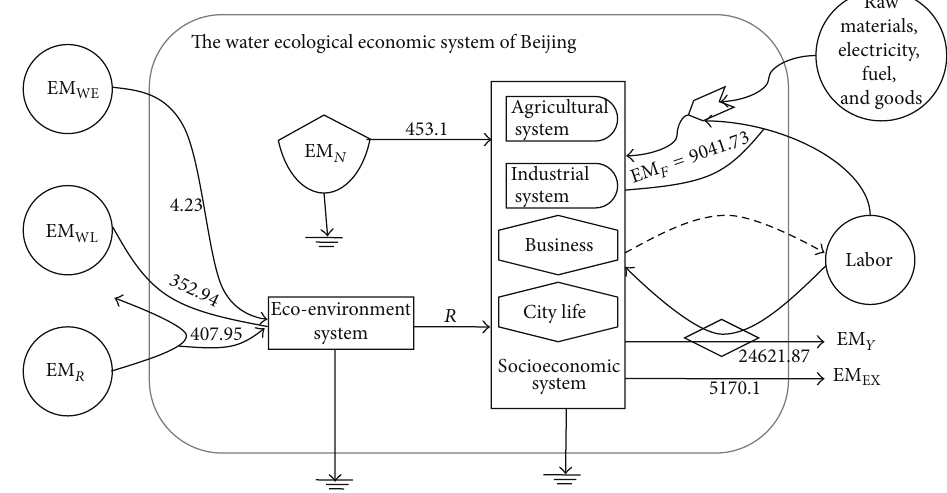
Figure 3: Aggregated figure of emergy flows for RWEES (units: emergy 10 20 sej).